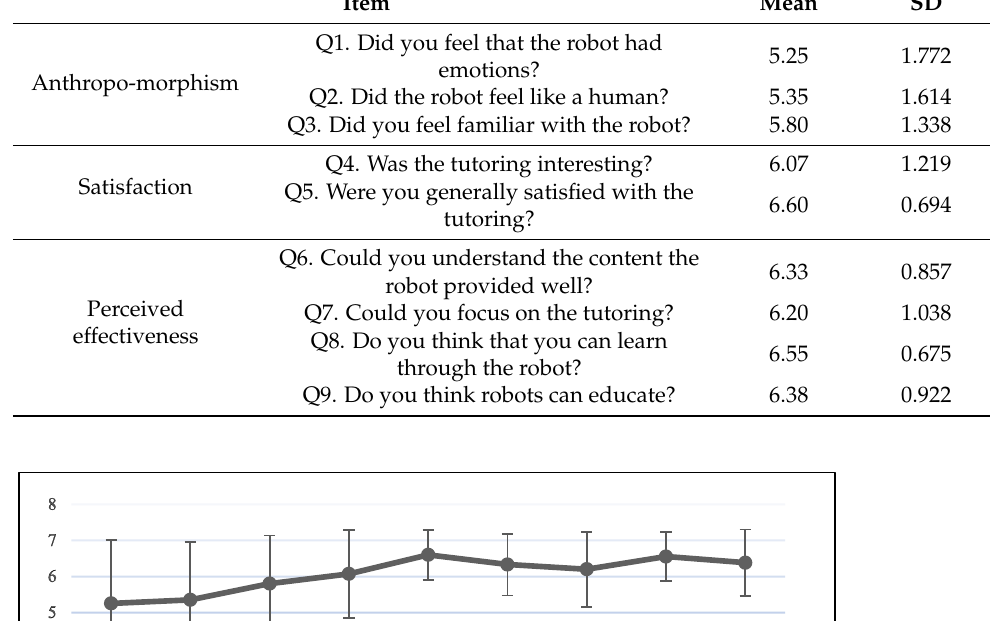
Table 4. Descriptive statistics of anthropomorphism and tutoring effect of the humanoid robot (N = 60).